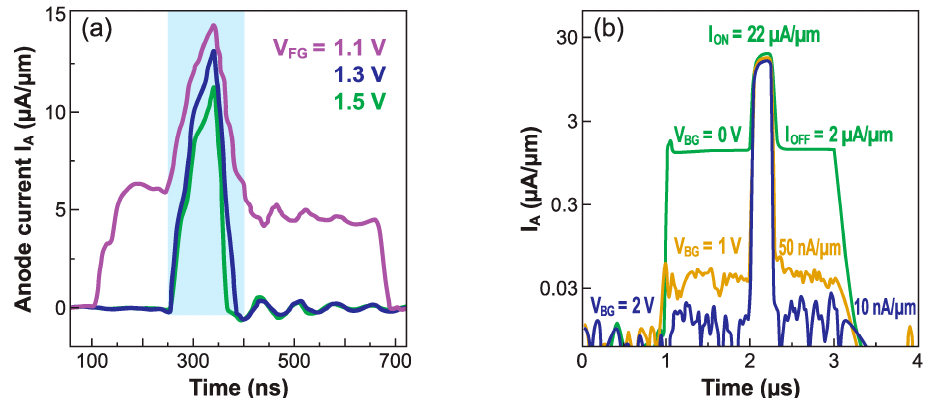
Figure 15. Current switch in response to a gate pulse showing the impact of ( a ) front-gate voltage (for V A = 0.8 V) and ( b ) ground-plane voltage V BG (V A = 1.1 V, V FG = 0.5 V, adapted from [32]). The gate pulse has a 0.5 V amplitude and varies, as in Figure 14b, between the indicated V FG value and a lower level.